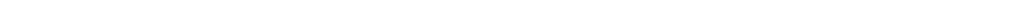
(see fi gure on previous page) Fig. 3 Human SERPINA3 overexpression in mouse NPCs induces cortical folding with expanded cortical lamination. a IF for CUX1 in P0 cKI f/ + brain section. Dashed square shows the curved cortex regions which were enlarged in the right side. Images 1, 2 and 3 are high-magni fi cation images. Dashed white lines show the boundary of CUX1 + layer. Arrows indicate gyri fi cation structures. Scale bars, 200 μ m (left), 100 μ m (right). b IF for TBR1, CTIP2 and SATB2 in P0 WT and cKI f/ + neocortex. The dashed white line and arrow show the thickness of positive layers. Scale bar, 50 μ m. c Quanti fi cation for the GI of the cortex at P0 (WT n = 4; cKI f/ + n = 7). d Quanti fi cation for the CUX1 + cell number in 100 µm-wide fi eld of cortex at P0 (WT n = 3; cKI f/ + n = 4). e Quanti fi cation for the TBR1 + cell number in 100 µm-wide fi eld of cortex at P0 (WT n = 4; cKI f/ + n = 6). Quanti fi cation for the CTIP2 + cell number in 100µm-wide fi eld of cortex at P0 (WT n = 4; cKI f/ + n = 5). Quanti fi cation for the SATB2 + cell number in 100 µm-wide fi eld of cortex at P0 (WT n = 4; cKI f/ + n = 5). f Protein levels of neuron markers (SATB2, TBR1, TUJ1, and NEUN) in cortex of P0 WT and cKI f/ + were measured by western blotting. β -actin was detected as a loading control. g Quanti fi cation for the protein level of SATB2, TBR1, TUJ1, and NEUN in WT and cKI f/ + cortex ( n = 4, 4, 6, and 3). h Staining for DAPI in P3 WT and cKI f/ + mice. Asterisks indicate gyrus and arrows indicate sulcus structures. White squares show the curved cortex region which were enlarged. Images 1 and 2 (DAPI) are high-magni fi cation images. Scale bars, 500 μ m (left) and 100 μ m (right). Two-tail unpaired t -test is used to analyze the data. n.s. no signi fi cant difference; P < 0.05 (*), P < 0.01 (**), P < 0.001 (***).